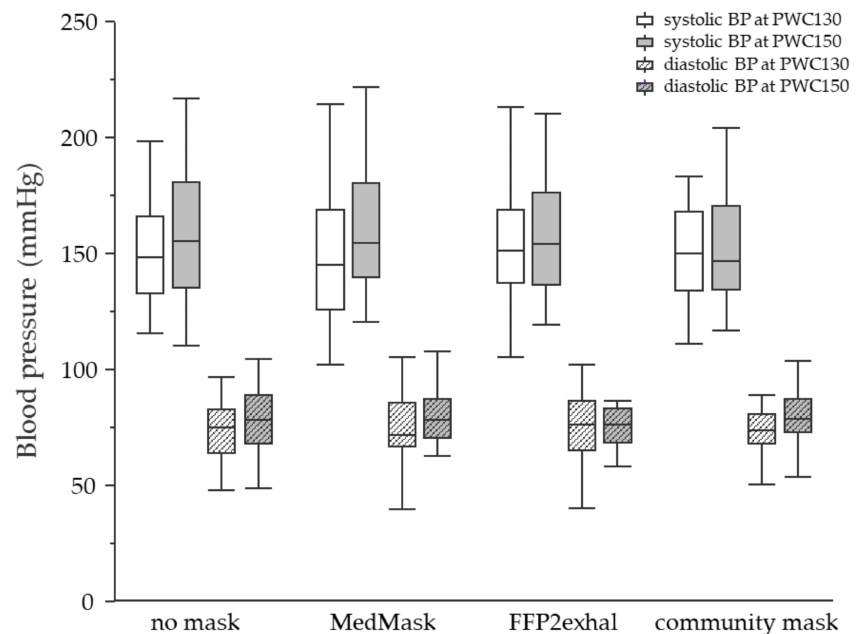
Figure 5. Systolic and diastolic blood pressure at the heart rate of 130 and 150 beats per minute using different face masks. Filled boxplots represent the systolic blood pressure and grey shaded boxplots represent blood pressure at PWC150. SpO2, saturation of peripheral capillary oxygen; PWC, physical working capacity; MedMask, medical face mask; FFP2exhal, filtering facepiece with exhalation valve.